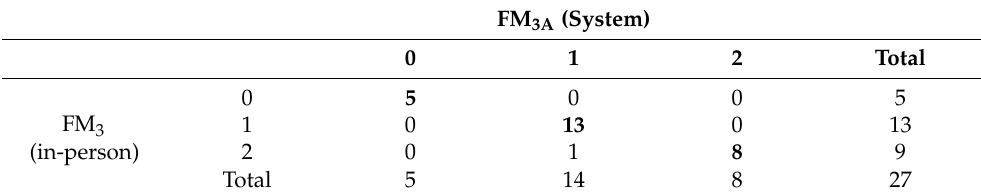
Table 9. Agreement of FM 3 and FM 3A .